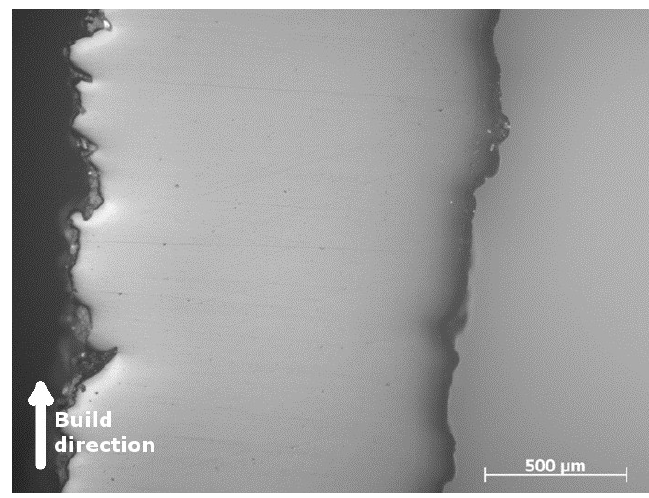
Figure 6. High-magnification optical micrograph showing 1.5 mm vertical strut produced with a standard scan strategy.